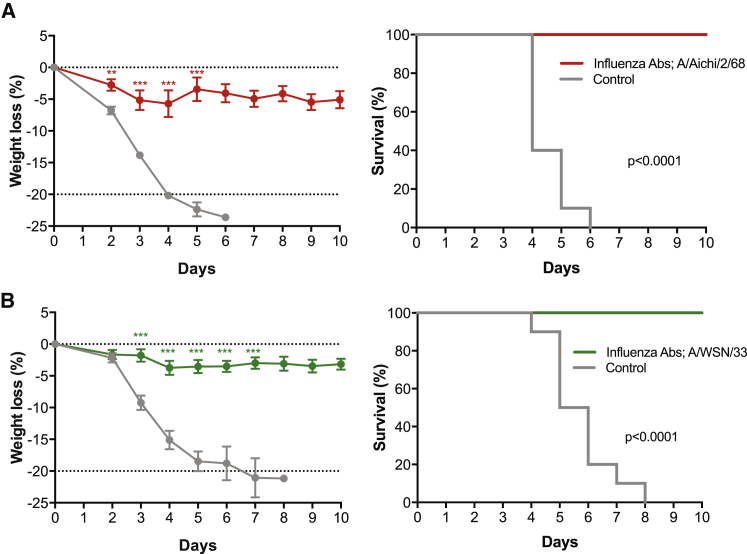
Heterosubtypic Immunity Protects Mice from Influenza Challenge(A and B) BALB/c mice surviving the A/Aichi/2/68 challenge (n = 7) or A/WSN/33 challenge (n = 9) (from Figure 3) were subsequently challenged intranasally 27.5 weeks after the initial challenge with (A) 39 LD50 A/WSN/33 (H1N1) or (B) 21 LD50 of A/Aichi/2/68 (H3N2), respectively. Control mice were 12 weeks of age at the time of challenge. (Left) Mean weight loss (%) ± SEM compared with day 0 and (right) survival (%) as depicted in Kaplan-Meier plots following challenge. For percent weight loss graphs, **p = 0.0016, ***p ≤ 0.0001.